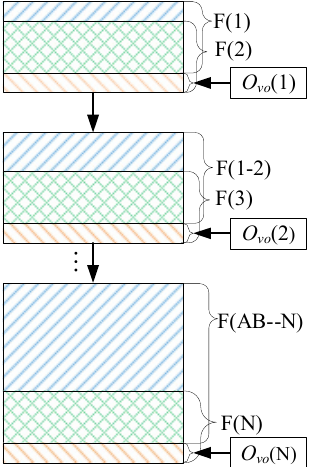
Figure 3. Generation process of cylindrical panorama.